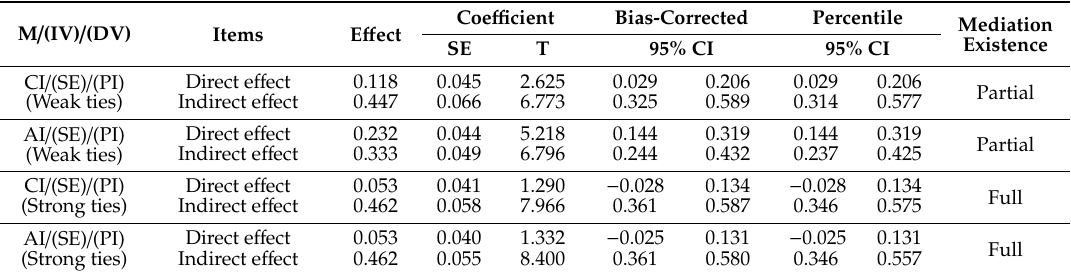
Table 5. Results of mediating e ff ects.